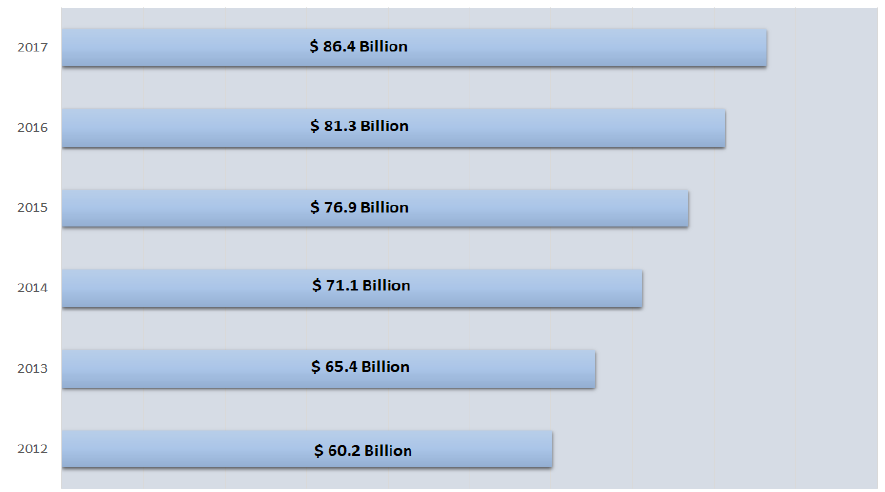
Figure 1. Worldwide spending on information security.